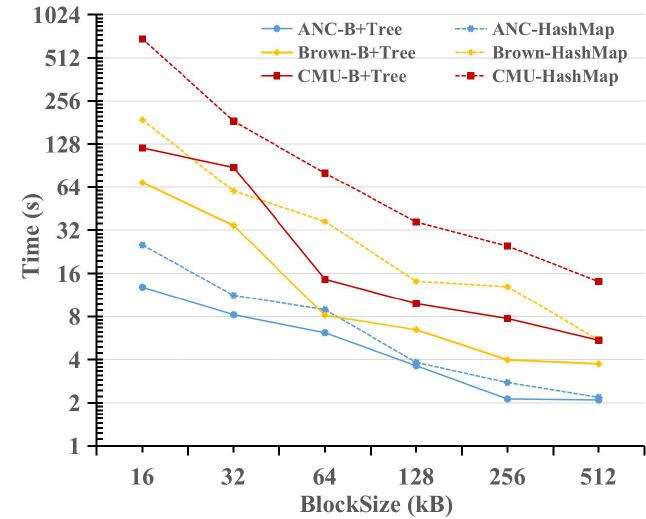
Figure 5. Comparison of the create time between B+Tree and HashMap.